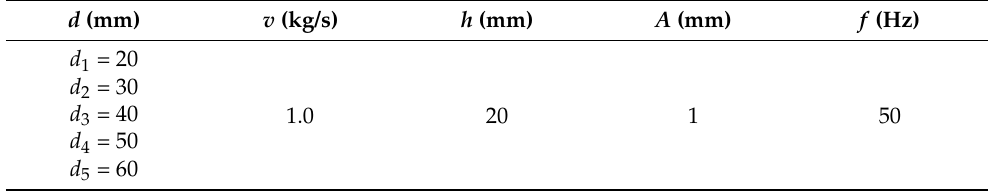
Table 6. Simulation parameters for different funnel